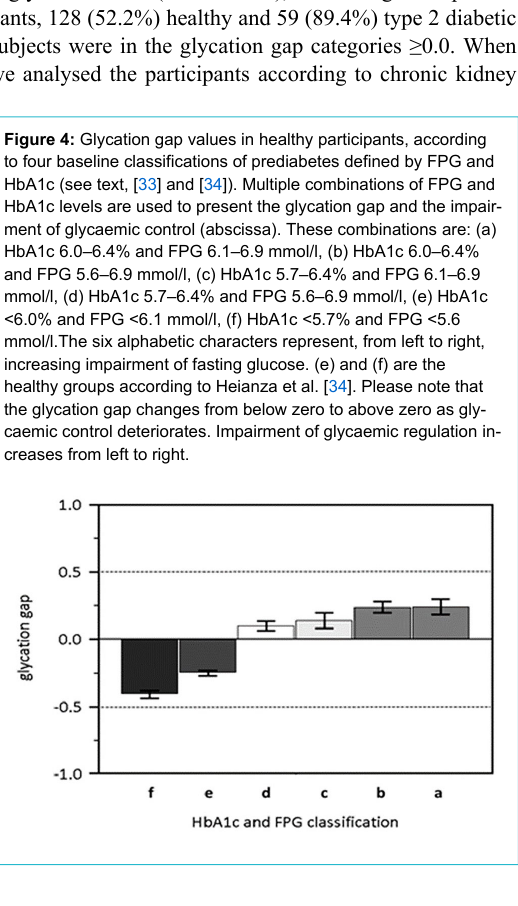
Table 2: Degree of insulin resistance relating to inflammatory, lipid and kidney clinical chemistry criteria in the healthy, non-diabetic cohort (n = 1248). HOMA-IR hsCRP Triglycerides